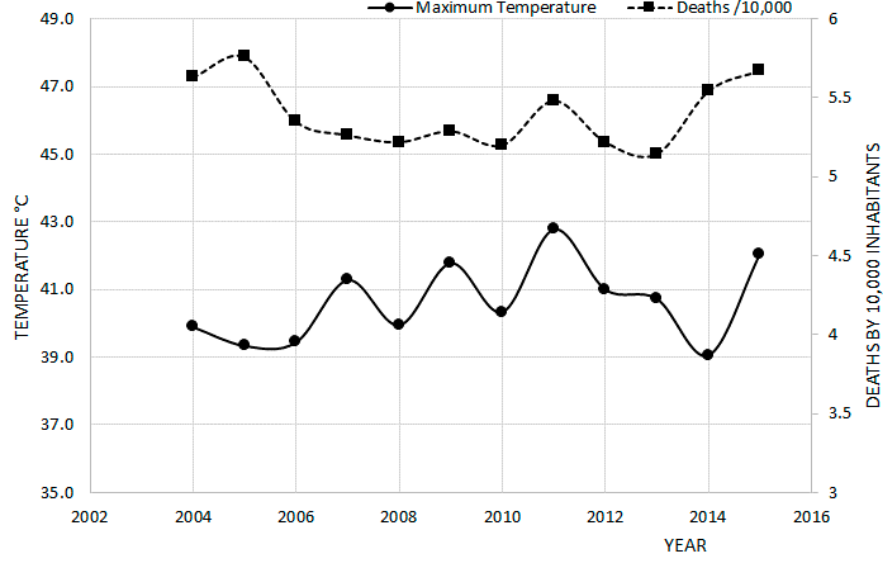
Figure 5. Maximum temperature and mortality rate (per 10,000 inhabitants) during August in Maricopa County (2004 to 2015).